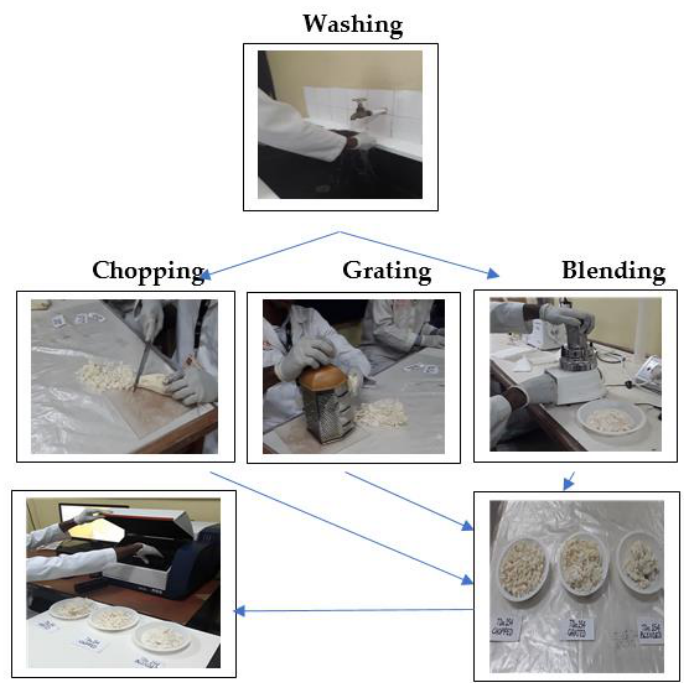
Figure 1. Workflow for sample preparation protocols for fresh yam (chopping, grating, and blending).